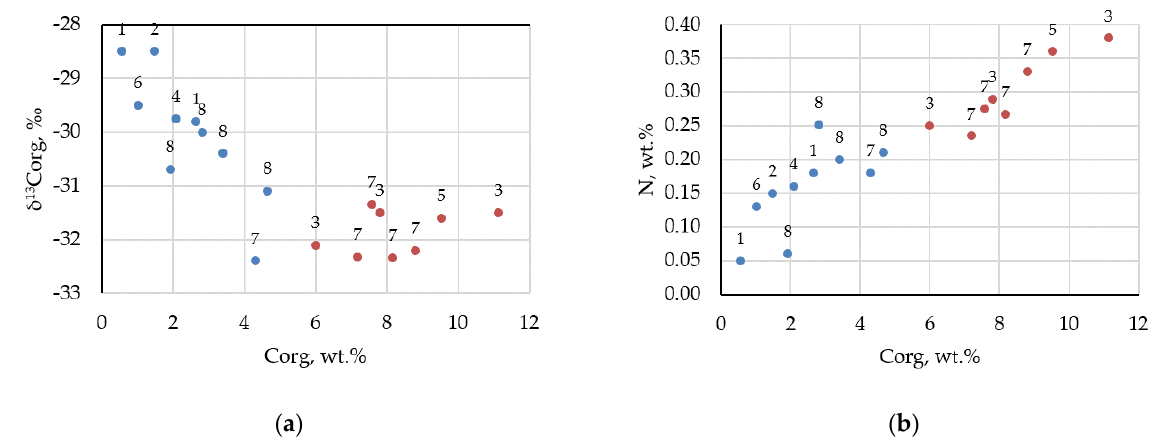
Figure 10. ( a ) Cross-plot of the elemental and isotopic composition of organic carbon. ( b ) Cross-plot of the elemental composition of nitrogen and organic carbon. The two series of samples represent rocks with C org < 5 wt.% (blue markers) and C org > 5 wt.% (red markers), and numbers correspond to geochemical members.